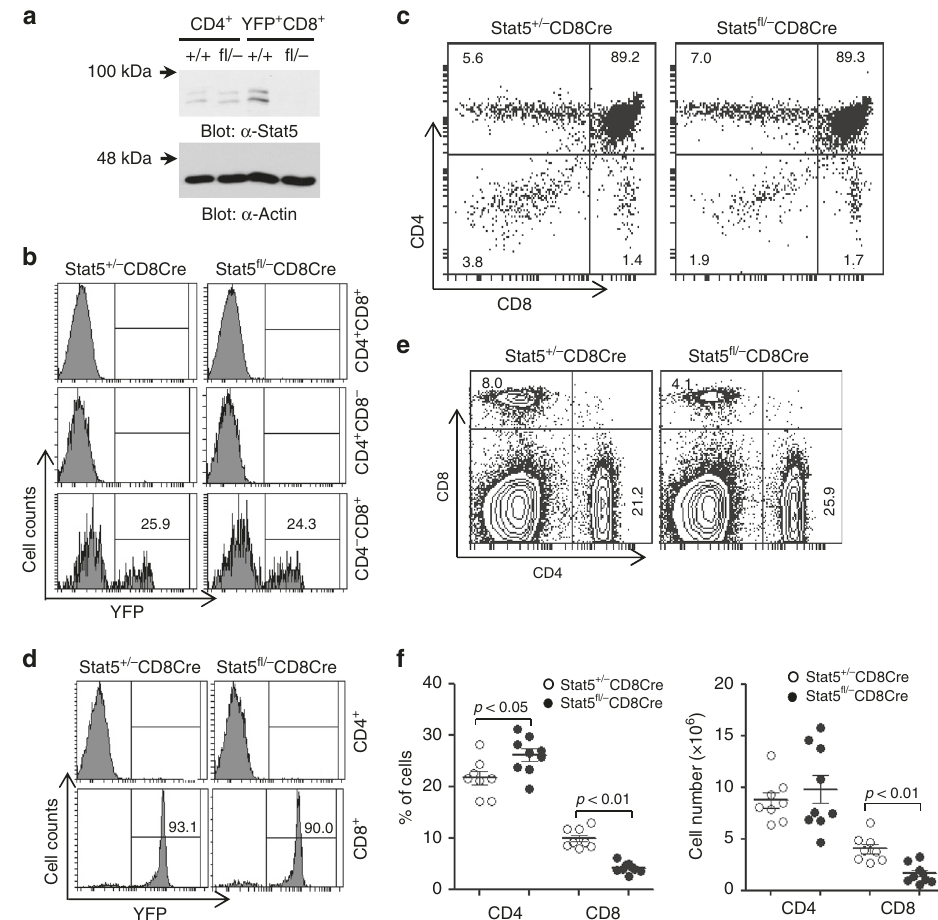
Fig. 1 Reduction of peripheral CD8 + , but not CD4 + , T cells in Stat5 fl / − CD8Cre mice. a Deletion of Stat5 in YFP + CD8 T cells. CD4 + and YFP + CD8 + T cells from Stat5 + / + CD8Cre/YFP ( + / + ) and Stat5 fl / − CD8Cre/YFP ( fl / − ) mice were subjected to Western blot analysis with the indicated antibodies. b CD8Cre- mediated Stat5 deletion in CD4 − CD8 + , but not CD4 + CD8 + or CD4 + CD8 − , thymocytes. Thymocytes from Stat5 + / − CD8Cre/YFP (Stat5 + / − CD8Cre) and Stat5 fl / − CD8Cre/YFP (Stat5 fl / − CD8Cre) mice were stained with anti-CD4 and anti-CD8 antibodies. Numbers indicate percentages of YFP + cells in the gated CD8 + population. c Normal development of thymocytes in Stat5 fl / − CD8Cre/YFP mice. Numbers indicate percentages of CD4 − CD8 − , CD4 + CD8 + , CD4 + CD8 − or CD4 − CD8 + thymocytes in the gated thymic lymphoid population. d CD8Cre-mediated Stat5 deletion in CD8 + , but not CD4 + , splenic T cells. Splenocytes were stained with anti-CD4 and anti-CD8 antibodies. Numbers indicate percentages of YFP + cells in the gated CD8 + population. e Marked reduction of splenic CD8 + T cells in Stat5 fl / − CD8Cre/YFP mice. Numbers indicate percentages of CD4 + and CD8 + T cells in the gated splenic lymphoid population. f Dot plots show percentages of CD4 + and CD8 + T cells (left) and the numbers of CD4 + and CD8 + T cells (right) in the spleen. Each dot represents an individual mouse and horizontal bars indicate mean values. Mean±SD is shown. P -values were calculated with the unpaired two-tailed Student ’ s t -test. Data shown are representative of 2 ( a ) independent experiments or obtained from 6 ( b , c ) or 8 ( d – f ) Stat5 + / − CD8Cre/YFP and 6 ( b , c ) or 9 ( d – f ) Stat5 fl / − CD8Cre/YFP mice. Source data are available as a source data fi